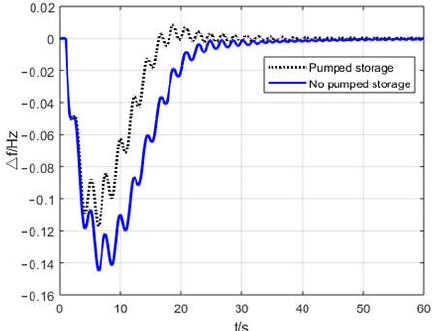
Figure 10. Frequency variation chart of the disturbance zone at pumping operation mode.